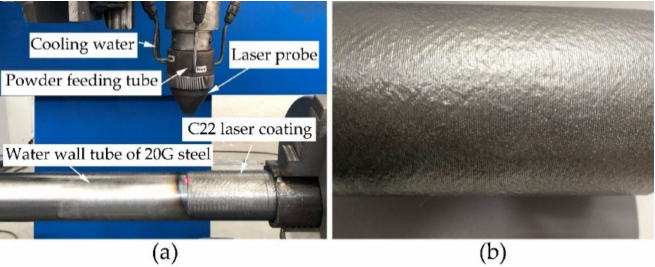
Figure 1. Photographs of: ( a ) laser-cladding setup; ( b ) C22 laser coating prepared on water wall tube surface of 20G